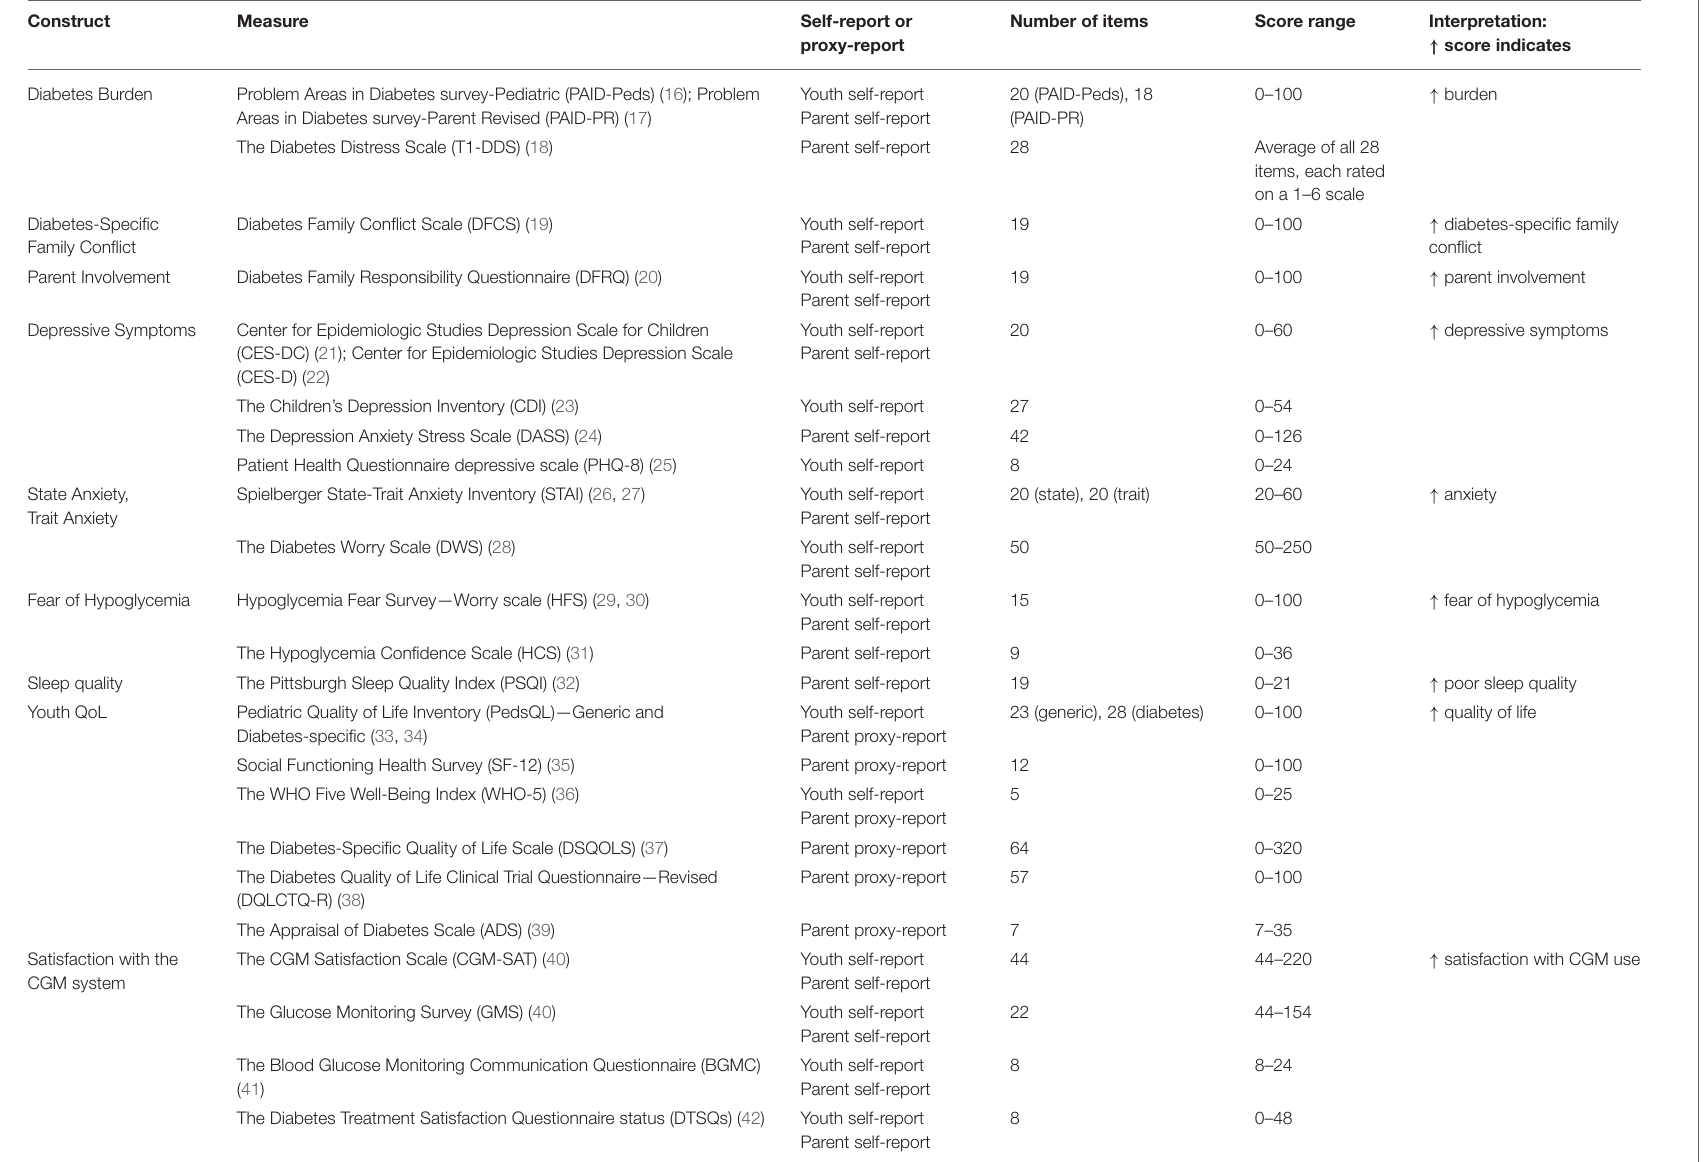
TABLE 1 | Review of psychological measures in children used in the studies, sorted by outcome. Construct Measure Self-report or